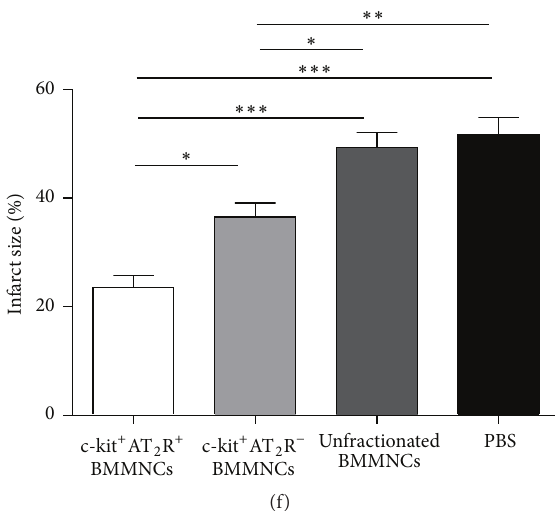
Figure 6: Echocardiographic evaluation: (a) M-mode images showing cardiac function. (b) Ejection fraction, (c) end-systolic volume, and (d) end-diastolic volume ( ∗ 𝑝 < 0.05, ∗∗ 𝑝 < 0.01, and ∗∗∗ 𝑝 < 0.001; 𝑛 = 6 for each group). (e) TTC staining of transverse sections and quantification of infarct size of each group ( ∗ 𝑝 < 0.05, ∗∗ 𝑝 < 0.01, and 𝑛 = 6 for each